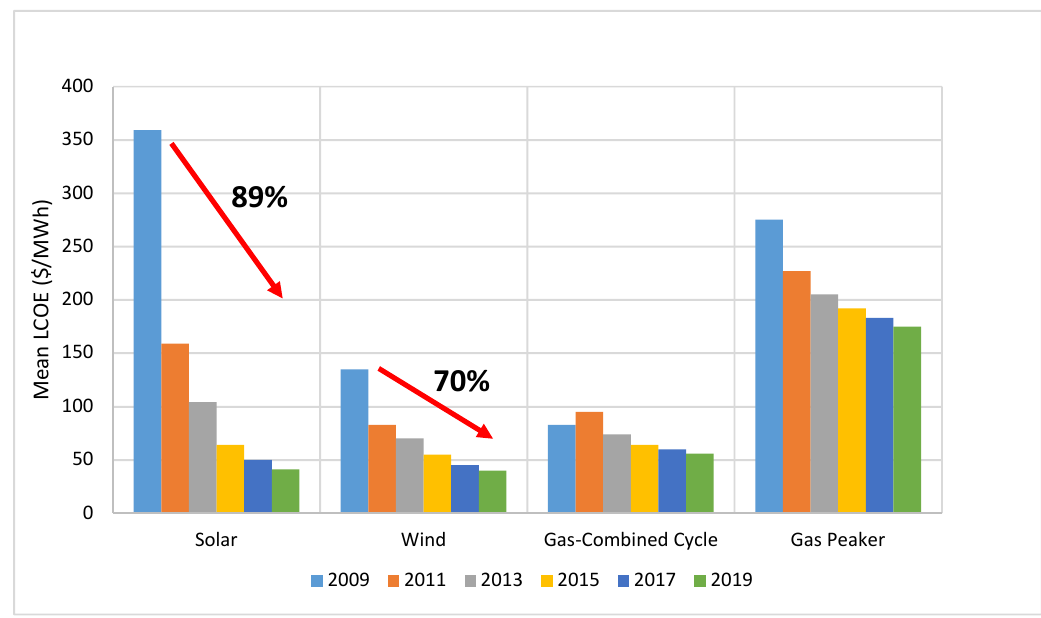
Figure 2. Renewables are getting cheaper. Unsubsidized LCOE (USD /MWh). 2009 to 2019 cost reductions: Solar: 89%, Wind: 70%. Data from LAZARD [1].